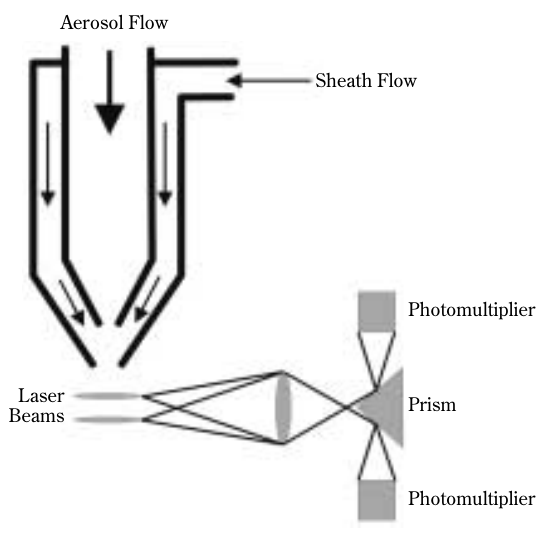
Fig. 10 Aerosol flow path and TOF detection system for the Aerosizer ® particle